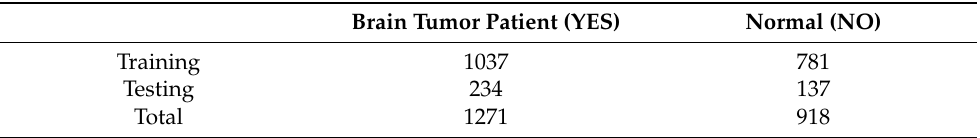
Figure 1. ( L ) MRI of a person without a brain tumor and ( R ) MRI of a person with a brain tumor. Table 1. Dataset distribution of training and testing after